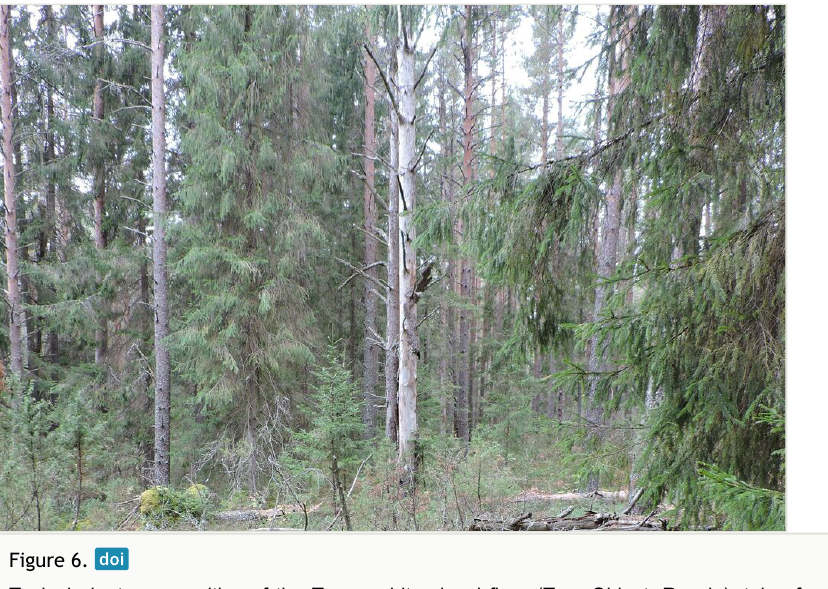
Typical plant communities of the Troyeruchitsa local flora (Tver Oblast, Russia): taiga forest (Vaccinio-Piceetea). Photo by the author (2016).